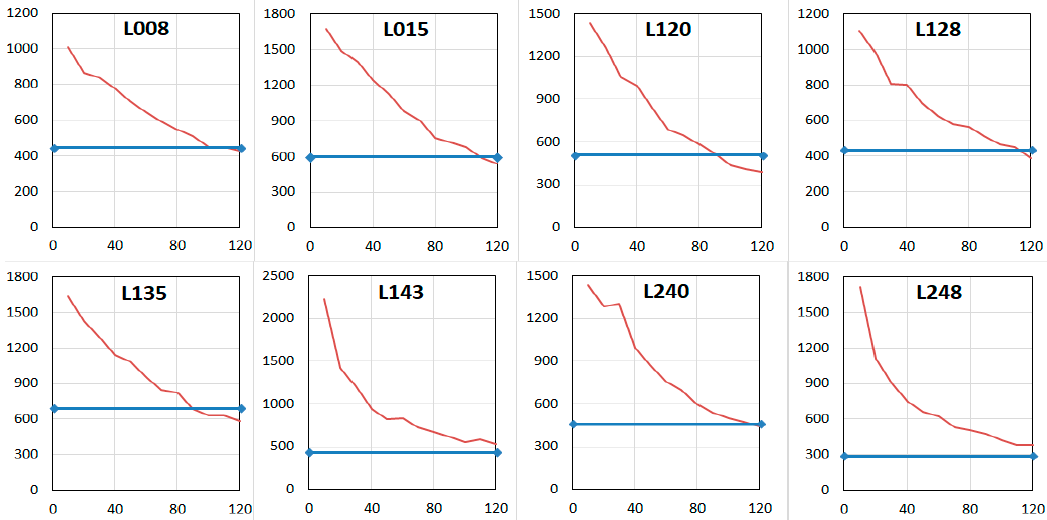
Figure 12. Variations of LBP feature vector components with lateral resolution in radial-polar sampling. The x -axis gives the values of n . The y -axis gives the range of values of an LBP feature shown in the chart title.